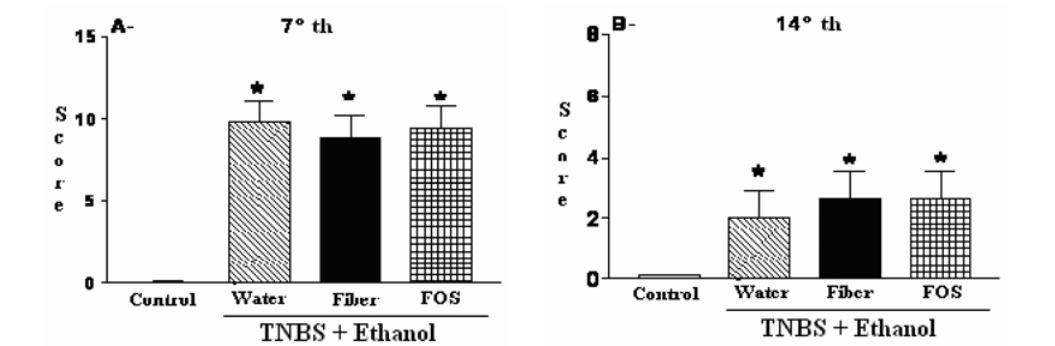
FIGURE 4 - Macroscopic colon lesions induced in rats by transrectal administration of trinitrobenzene sulphonic acid (TNBS) dissolved in ethanol were not inhibited by supplementation with soluble fiber or fructooligosaccharide (FOS). Colon lesions were evaluated on the 7th day (Panel A) or the 14th day (Panel B).. The results are expressed as average values ± MSE per group eight animals. (*) p <0.05 compared to the control group. Kruskal Wallis test.